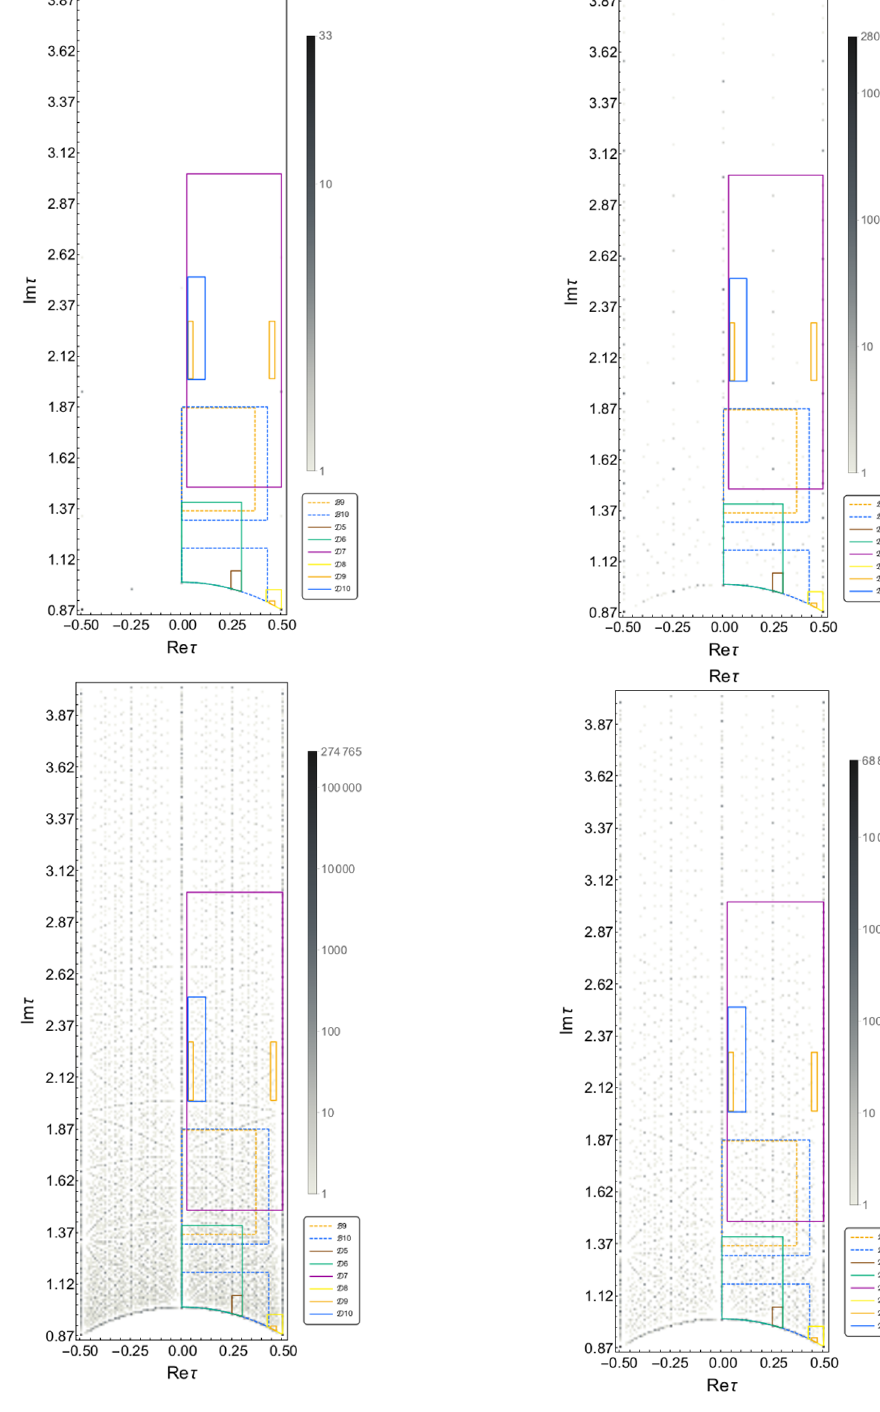
Figure 4 . Phenomenologically predicted moduli values vs. the complex structure modulus from the string landscape for N max = 10 ; 100 ; 500 ; 1000, clockwise from top left. (cid:13)ux